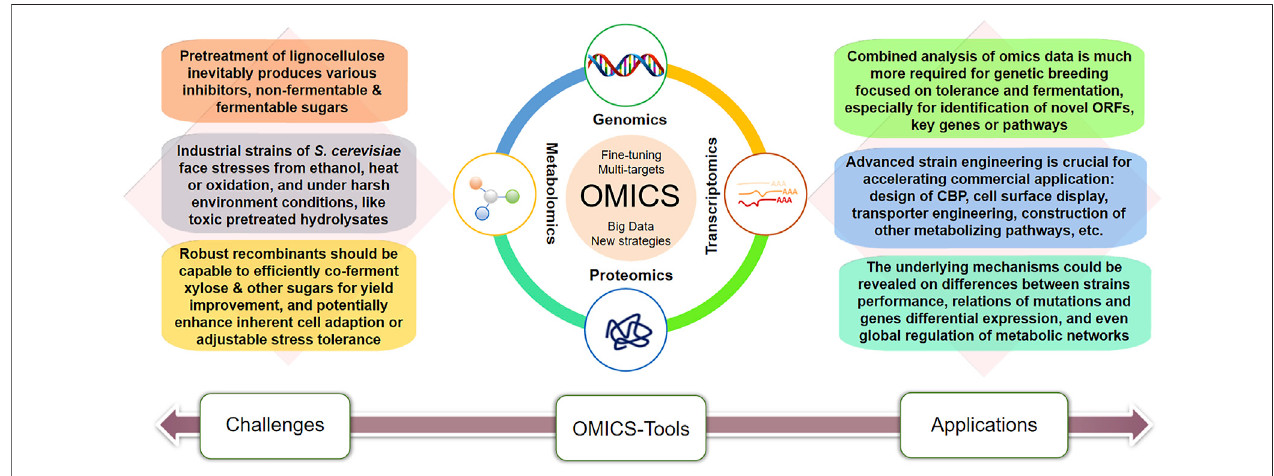
FIGURE 3 | Research strategy of stress tolerance improvement using “ OMICs ” -based technologies for the 2G fuel ethanol with challenges and applications.